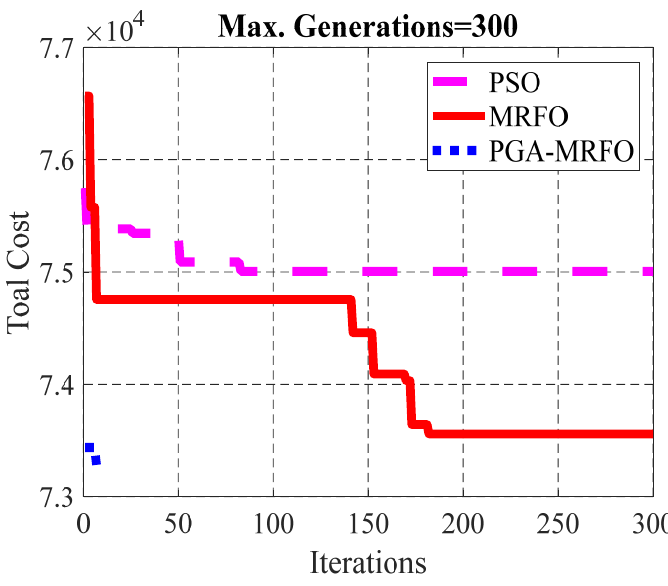
Figure 15. Converges curves for UC problem—Case 1 at max. Generations = 300.